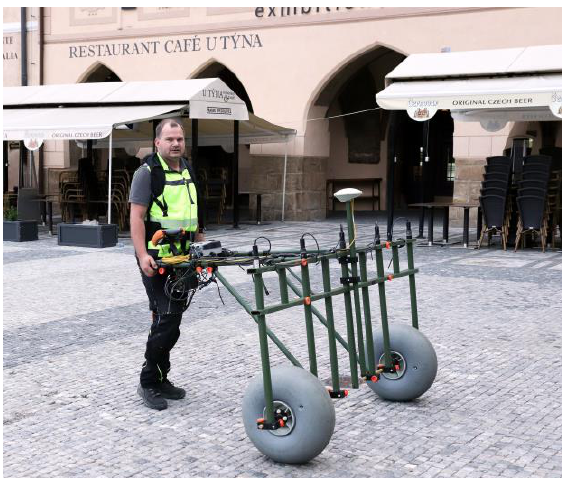
Figure 4. The multichannel magnetometer for